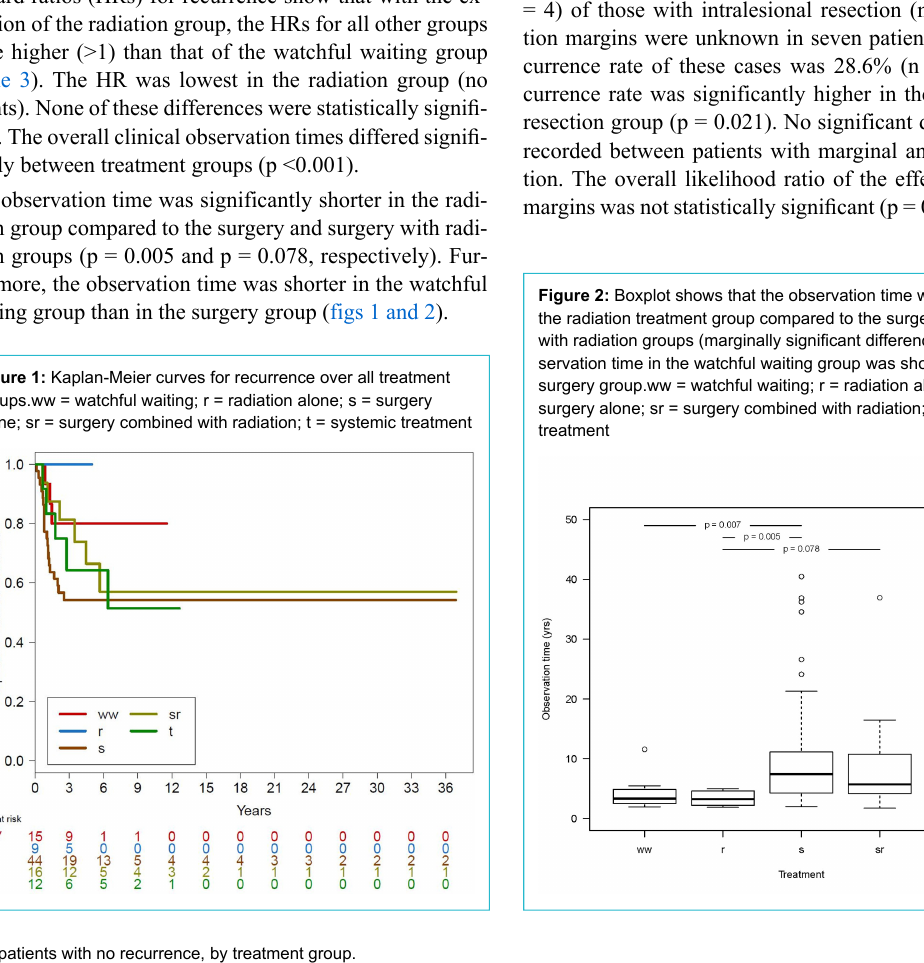
Table 2: Follow-up times (years) in patients with no recurrence, by treatment group.